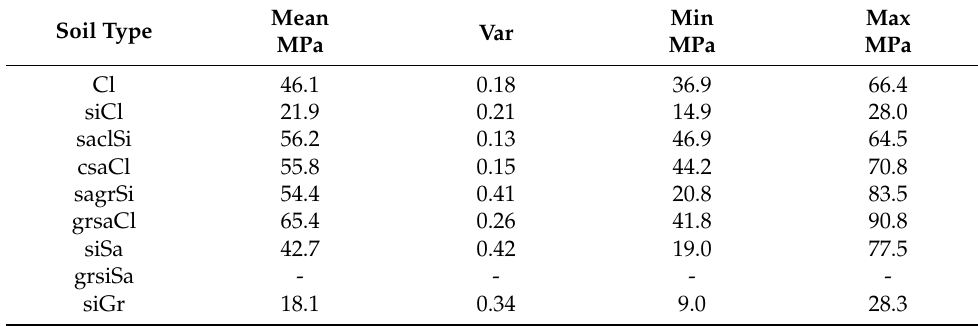
Figure 12. Resilient modulus M r,eff for individual soil classes — uncensored data. Table 4. Statistics of resilient modulus M r,eff for uncensored